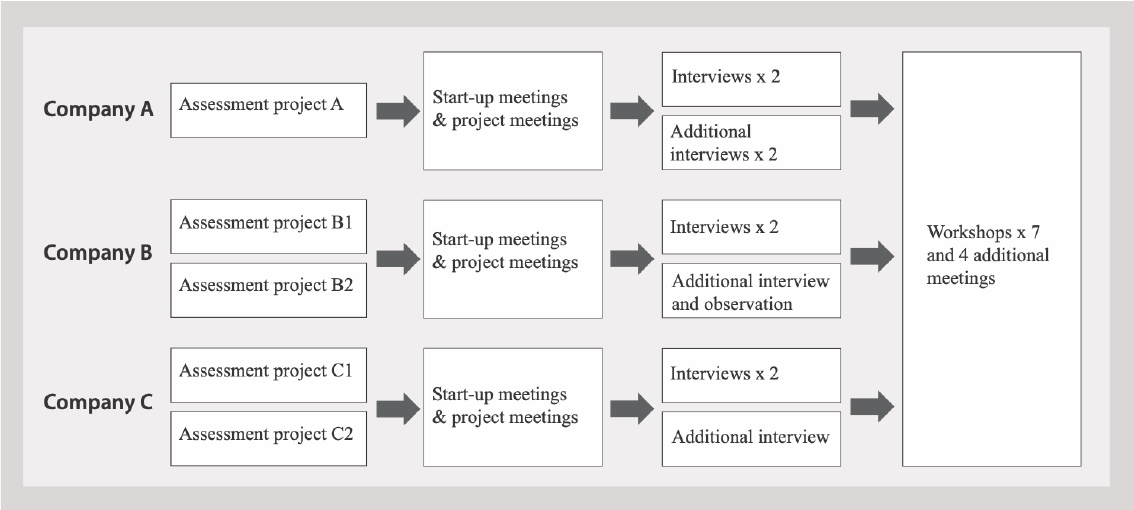
Fig. 4. Overview of the empirical material used in the article Workshops and meetings. Both workshops and interviews gave access to rich data (Maxwell, 2013) that provided information from both the perspectives of single individuals and each of the organizations that hosted the assessment groups that were not as accessible in the intervi-